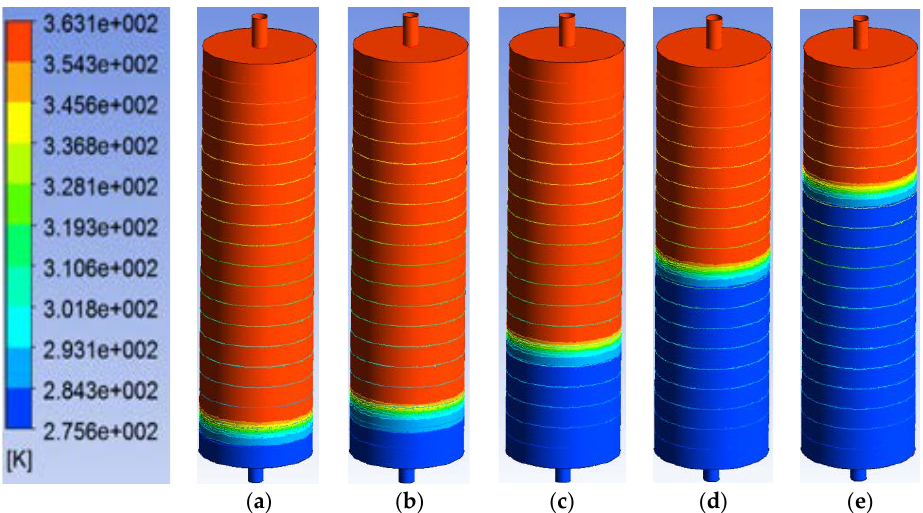
Figure 14. TES-1 at 90 °C: ( a ) 400 s; ( b ) 500 s; ( c ) 800 s; ( d ) 1200 s; ( e ) 1600 s.